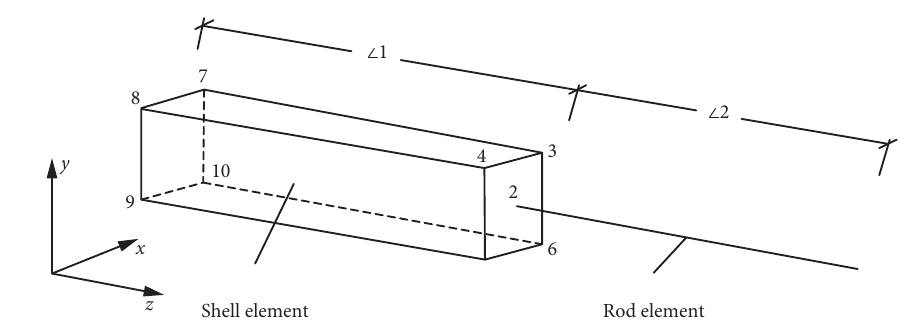
Figure 7: Diagram of the FMEM.